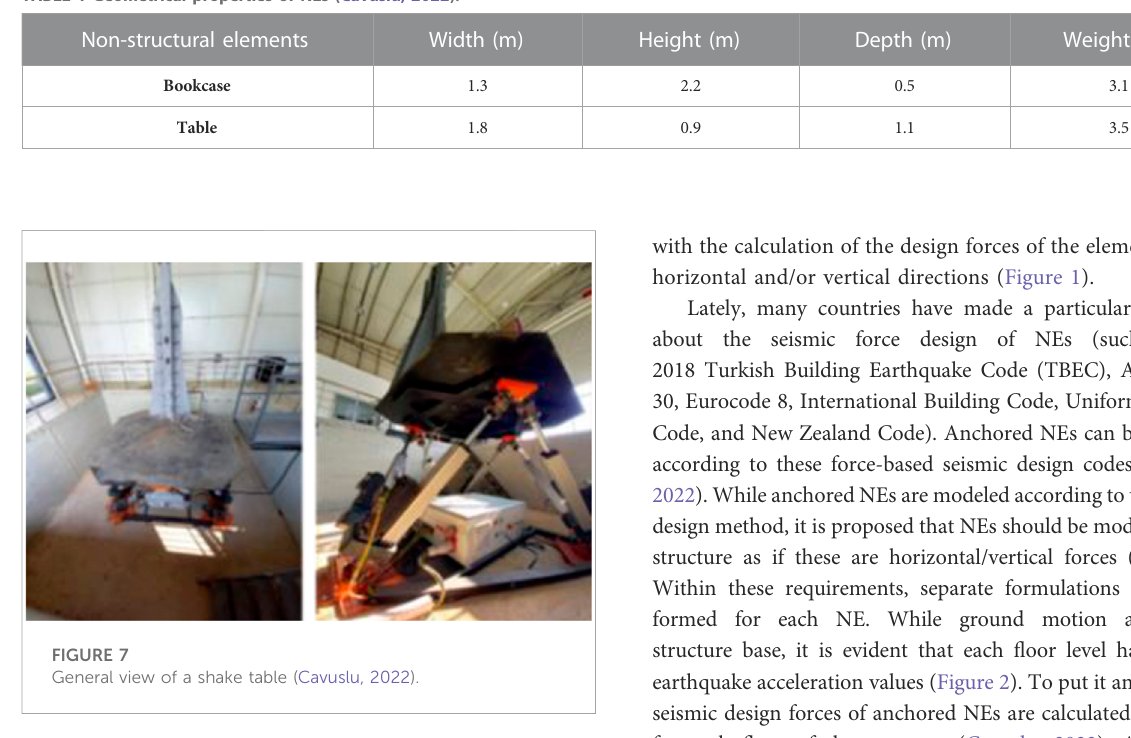
TABLE 1 Geometrical properties of NEs (Cavuslu, 2022).